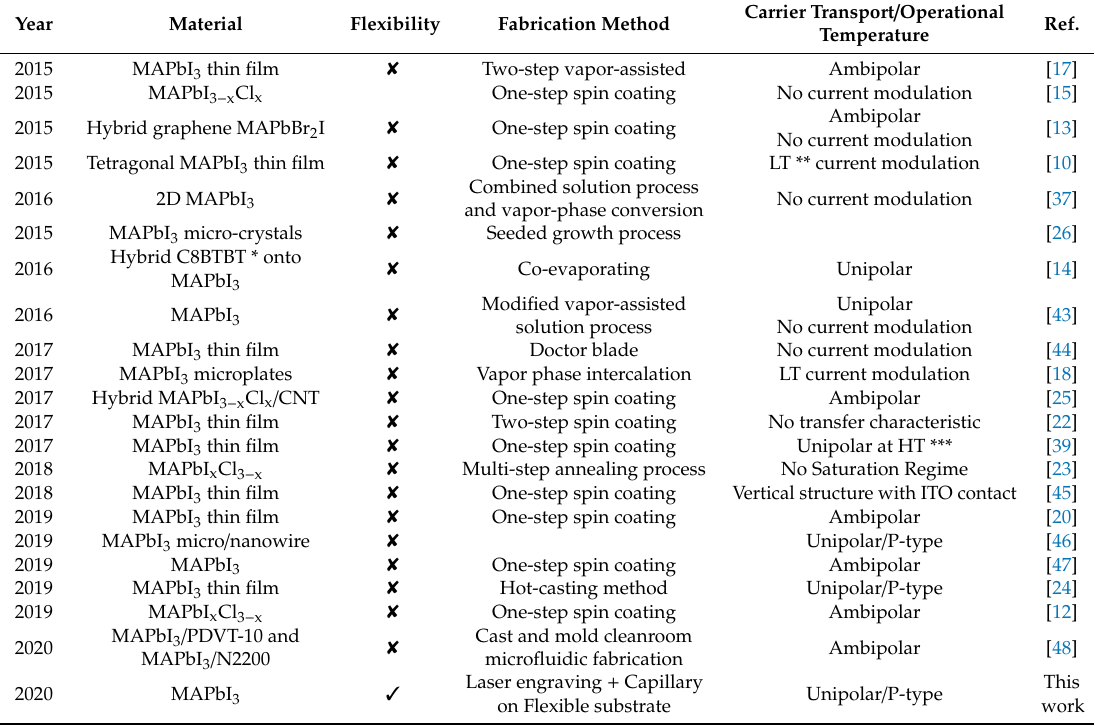
Table 1. Summary of fabricated MAPbI 3 -based